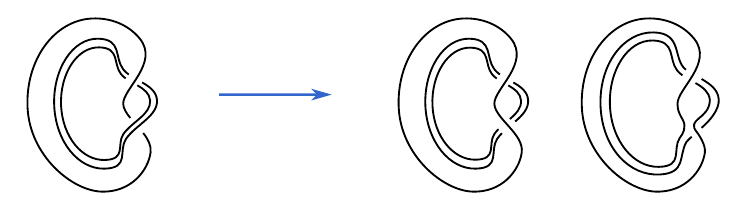
Figure 12. Skein relation for